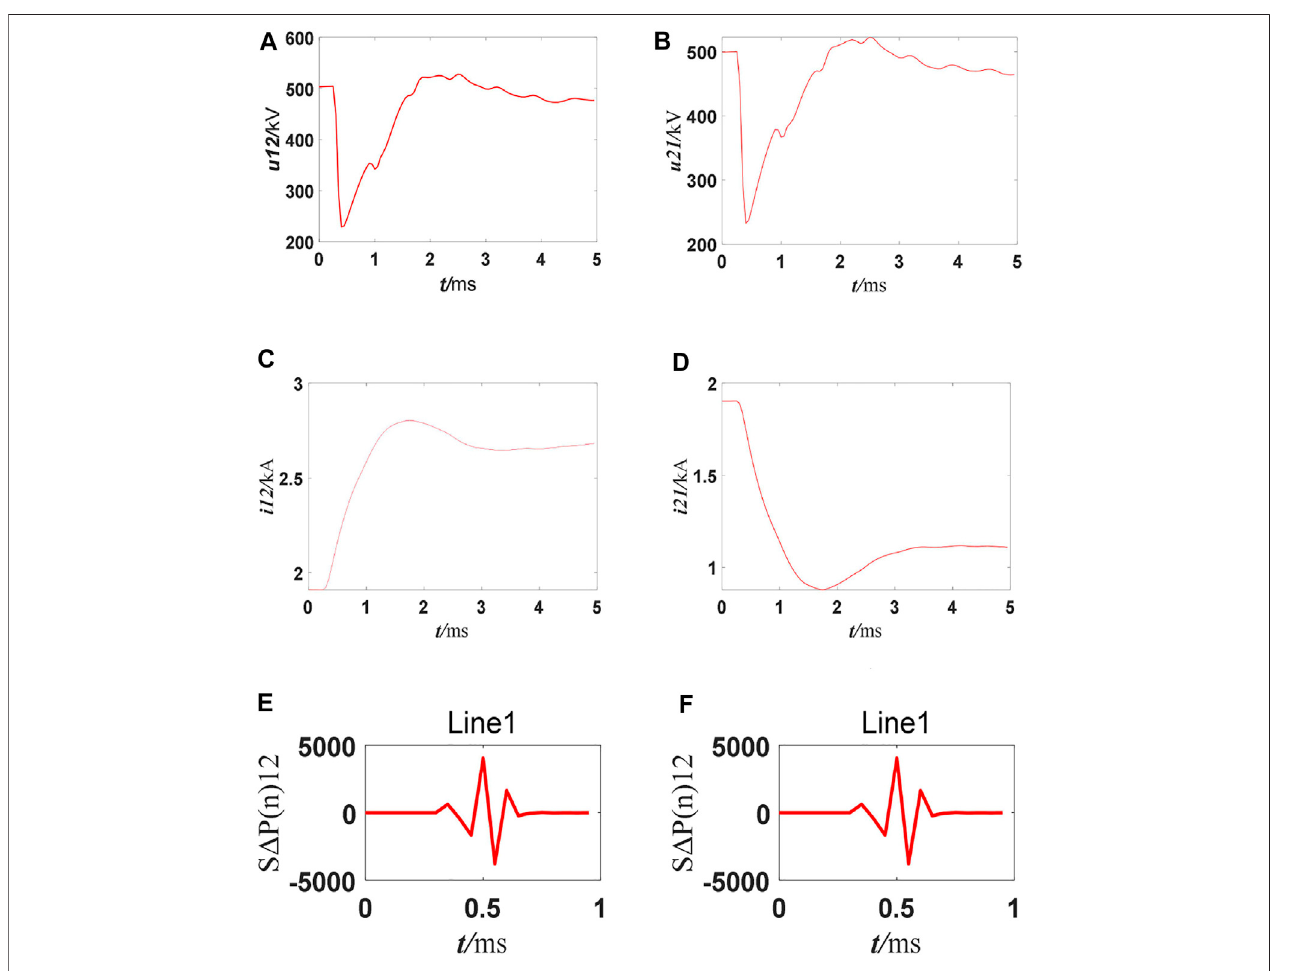
FIGURE 5 | Voltage, current, and S Δ P(n) waveform SOD transformation for line1 positive pole fault. (A) First-end positive fault voltage waveform; (B) Terminal positivefaultvoltage waveform; (C) First-end positivefault currentwaveform; (D) Terminal positivefaultcurrentwaveform; (E) Line1headend S Δ P(n)K (cid:1) 4,037; (F) End of line 1S Δ P(n) K (cid:1)